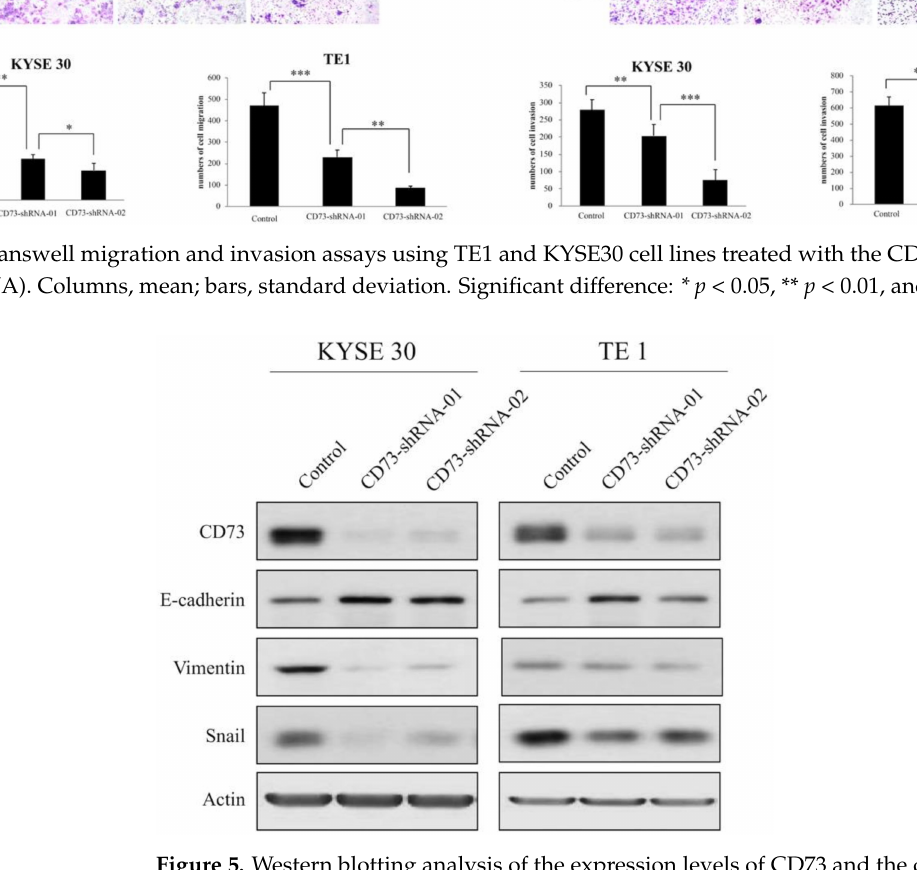
Figure 5. Western blotting analysis of the expression levels of CD73 and the downstream signaling pathways in the TE1 and KYSE30 cell lines. The protein expression profiles of CD73, E-cadherin, vimentin, and snail were examined in the presence or absence of CD73-shRNA treatment in the ESCC cells via Western